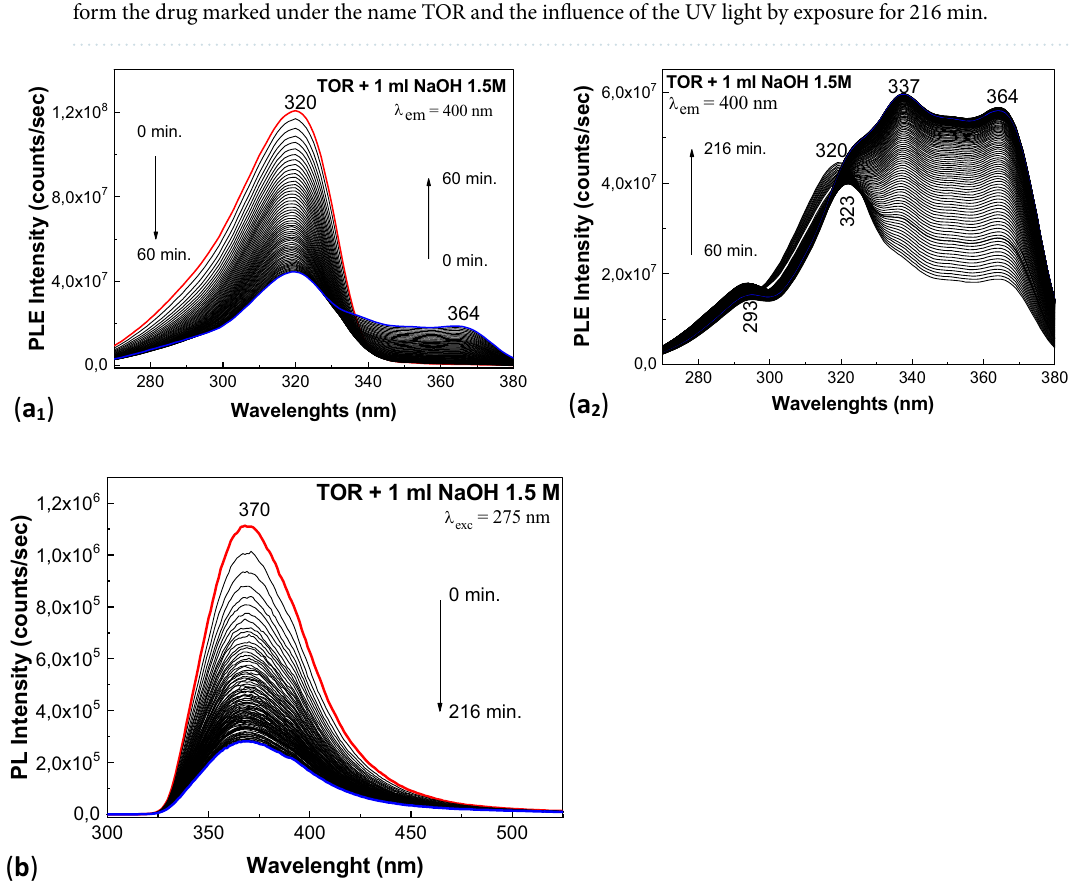
Figure 5. PLE ( a 1 , a 2 ) and PL( b ) spectra of the aqueous solutions of 2 ml ATC 2 mg/ml in the presence of excipients form the drug marked under the name TOR interacted with 1 ml NaOH 1.5 M and the influence of the UV light by exposure, time of 216